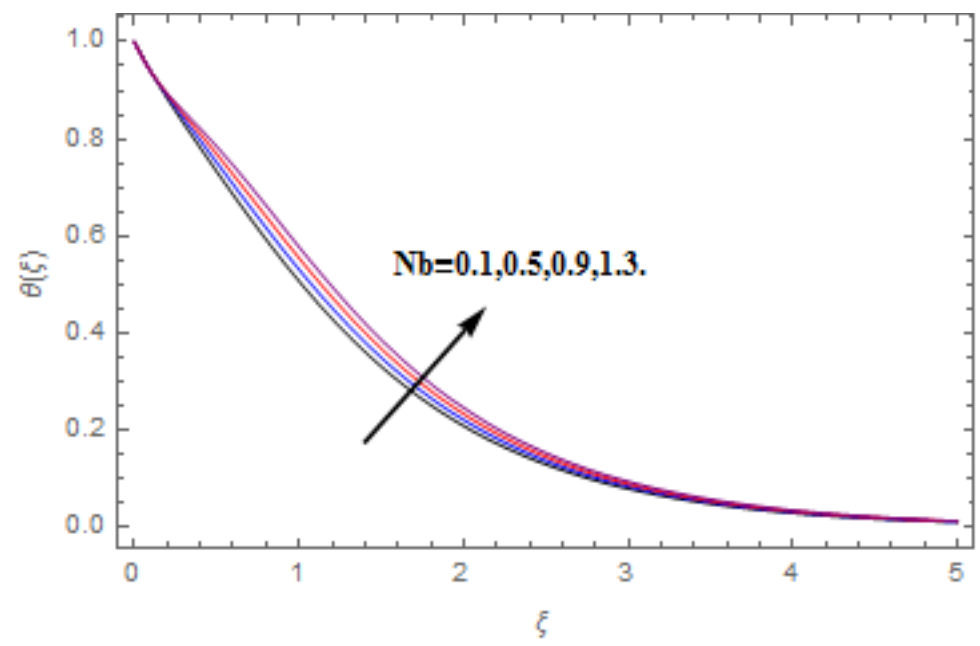
Figure 14. Varation in θ ( ξ ) against Nb , when M = ψ = 0.2, Nt = 0.5, Le = 1.0, Ec = 1.0, Pr = 1.2, γ = 0.1, κ =